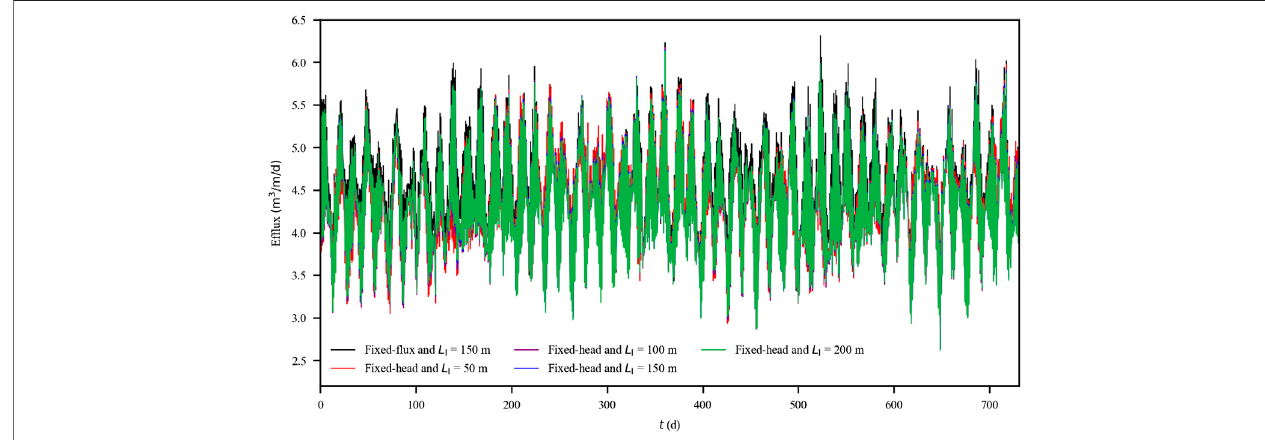
FIGURE 3 | Averaged per unit width water ef fl ux (i.e., submarine groundwater discharge) every 12.42 h for the cases with fi xed- fl ux ( L I (cid:1) 150 m) and fi xed-head ( L I (cid:1) 50, 100, 150, and 200 m) inland boundaries. Note that the lines are largely overlapped.